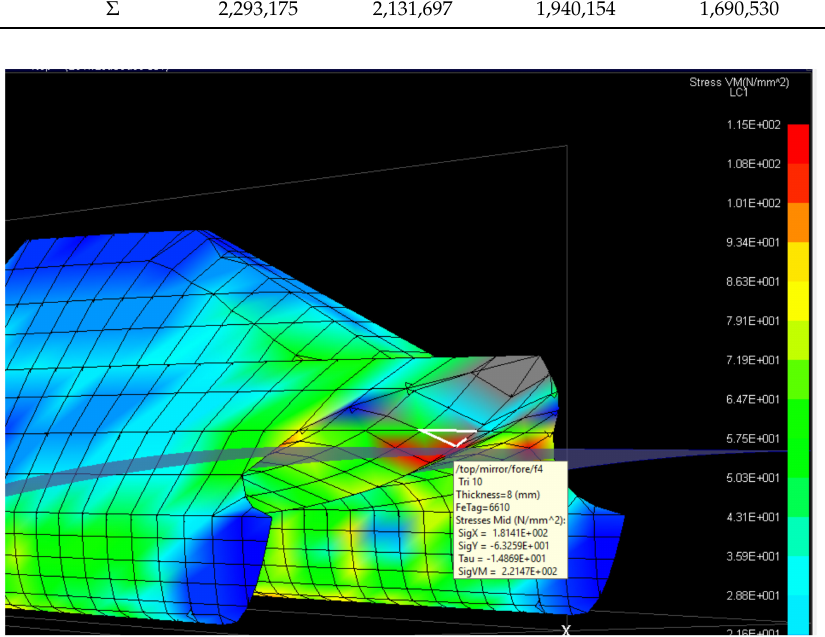
Figure 10. Stress values for LS3 loading case.